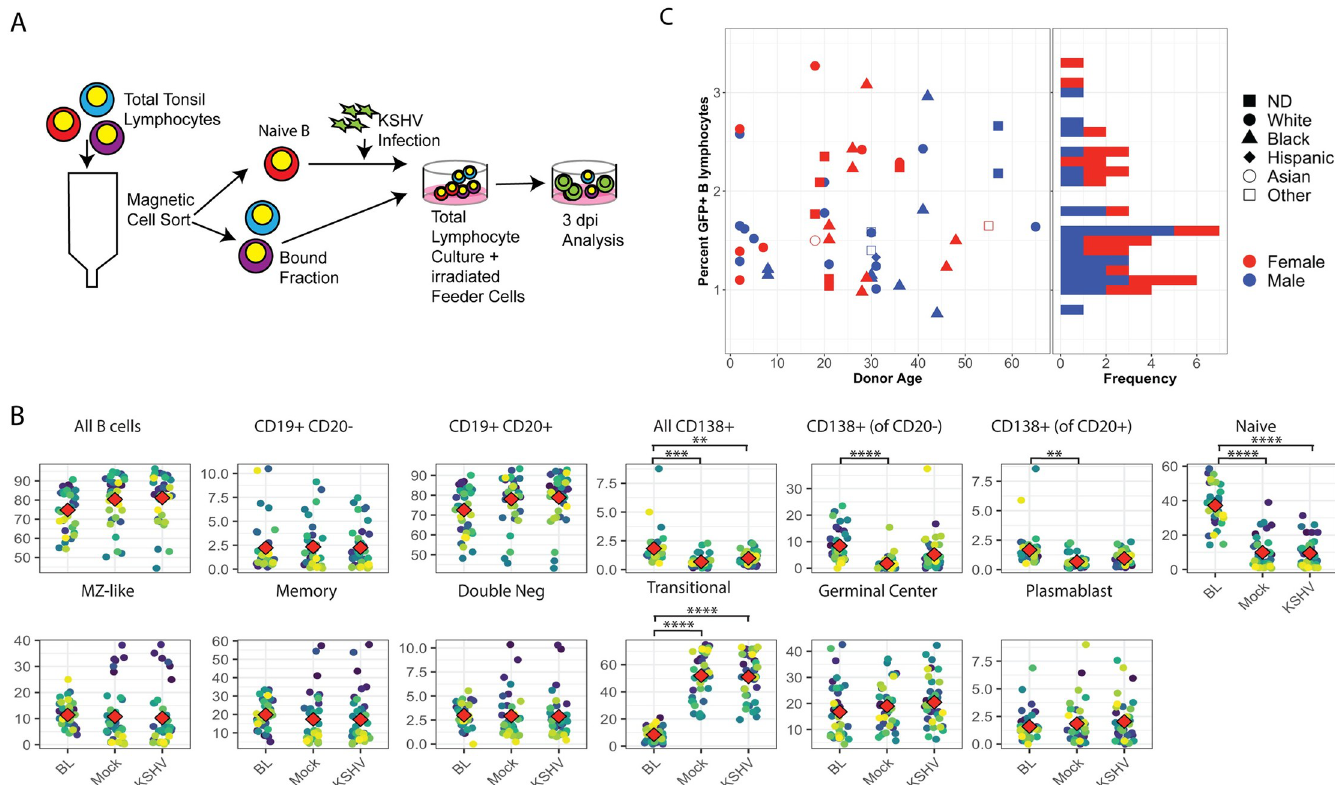
Fig 2. Tonsil-derived B lymphocytes from diverse donors display variable susceptibility to KSHV infection. (A) Schematic of lymphocyte infection procedure. Untouched na ï ve B cells are magnetically separated from total lymphocytes and 1e6 na ï ve B cells are infected per condition. Following infection, bound fractions are added back to reconstitute a total lymphocyte environment and cells are plated on X-ray irradiated CDw32 feeder cells. Analysis is performed by flow cytometry at 3 days post-infection for B cell lineage markers as shown in S1 Fig and Table 2 and GFP reporter expression for KSHV infection. (B) The effect of KSHV infection and the culture system on overall B cell lineage frequency was examined by comparing the frequency of B cell lineages at baseline (BL, unmanipulated samples) and 3 days post infection in Mock infected and KSHV infected cultures. Student’s T test was used to determine statistical significance for all comparisons �� p < 0.004, ��� p < 0.0002, ���� p < 1e-6 (C) Infection frequency data for viable, CD19+GFP+ lymphocytes at 3 dpi n = 50 from 40 tonsil specimens with biological replicates for 10 specimens displayed with respect to donor age (x-axis, left panel), sex (color), and self-reported race (shape, left panel). The histogram in the right panel is included to show the distribution of infection frequencies with the majority of infections resulting in 1–2% GFP+ B lymphocytes at 3